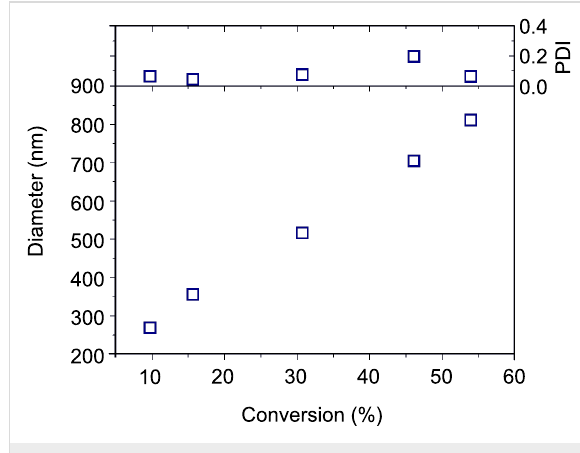
Figure 4: Evolution of molecular weights of free and grafted poly(VBC) chains with conversion.